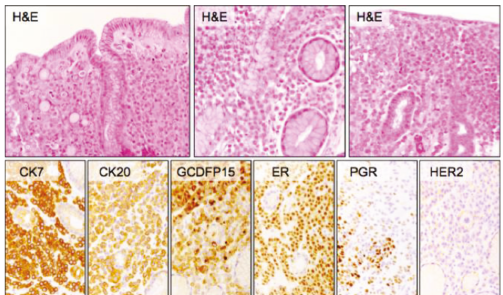
Figure 1: Histology con fi rmed localization of adenocarcinoma with immunohistochemistry: ER 90%, PgR 35%, CK7 3+, GCDFP-15 3+, and HER2